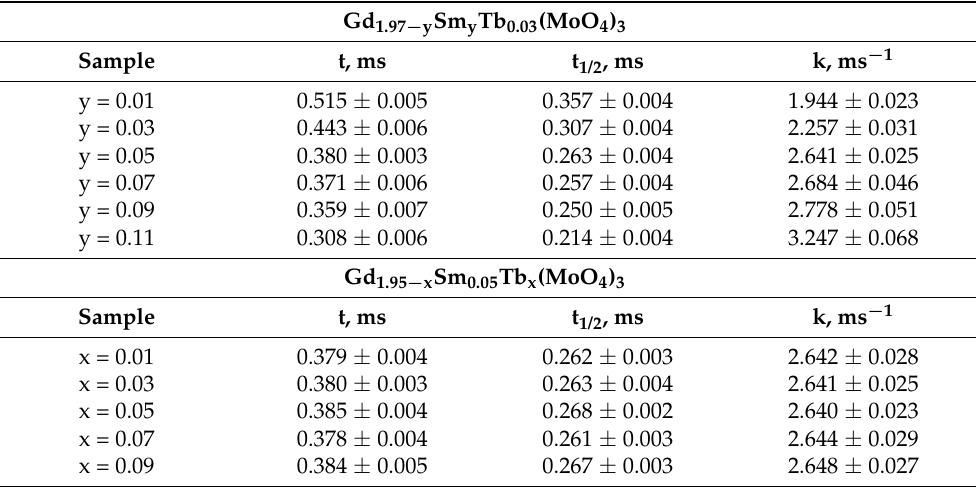
Figure 5. Decay curves recorded for ( a ) Gd 1.97 − x Sm x Tb 0.03 (MoO 4 ) 3 and ( b ) Gd 1.95 − x Sm 0.05 Tb x (MoO 4 ) 3 . Table 3. Lifetime ( τ ), decay half-life ( τ 1/2 ) and decay rate